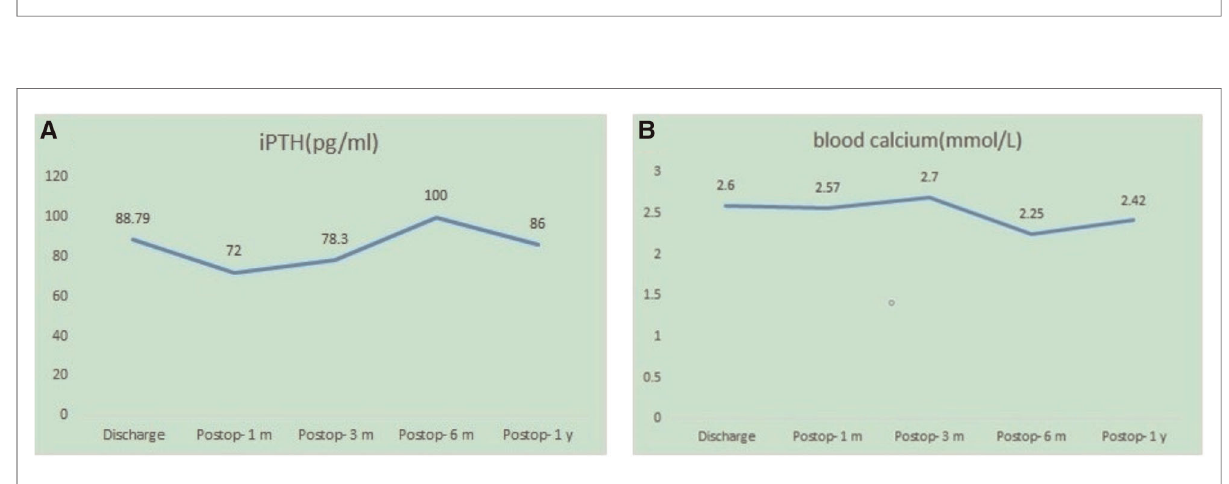
FIGURE 3 Large parathyroid in the right anterior mediastinum after removal. ( A ) Length of the mass was approximately 7 cm; ( B ) width was approximately 3.5 cm.